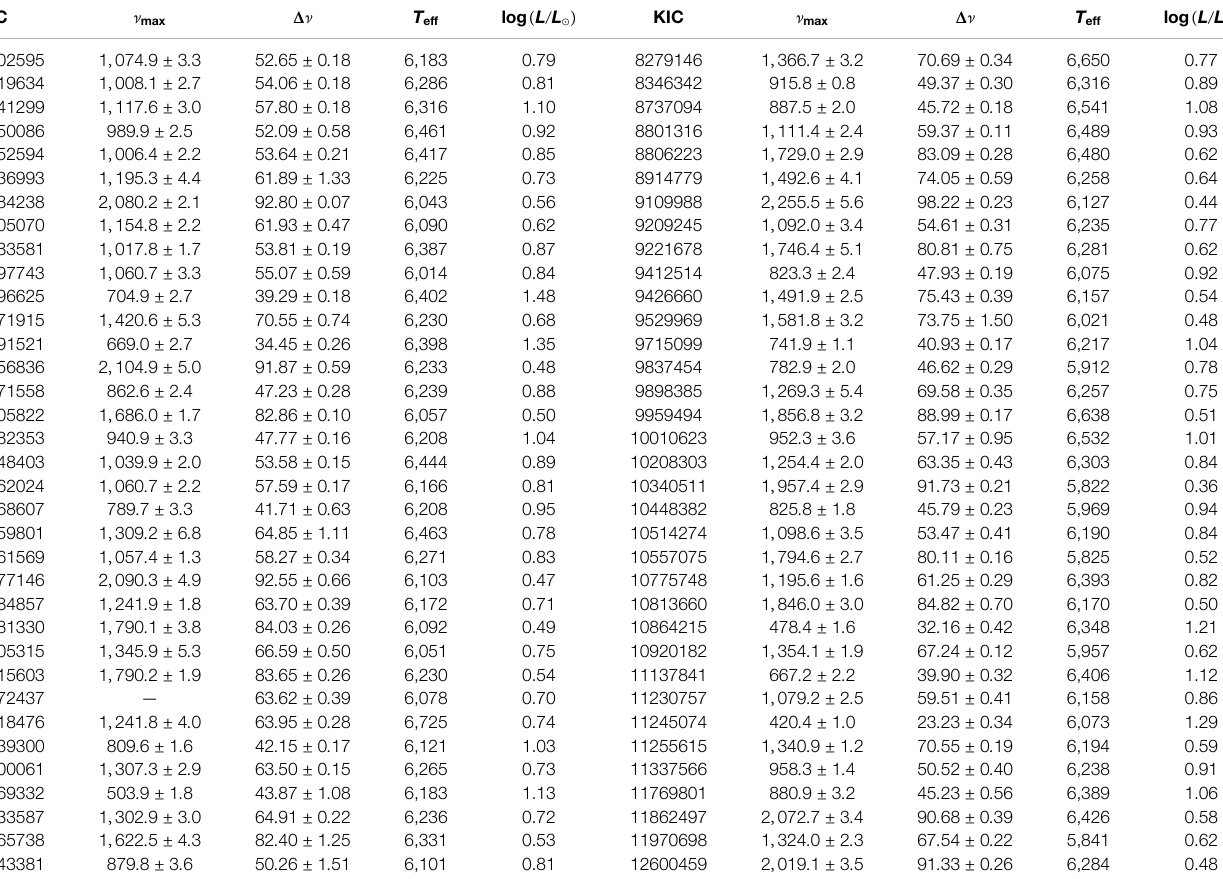
TABLE 2 | Newly-discovered stars with solar-like oscillations. The columns are the same as Table 1 . KIC